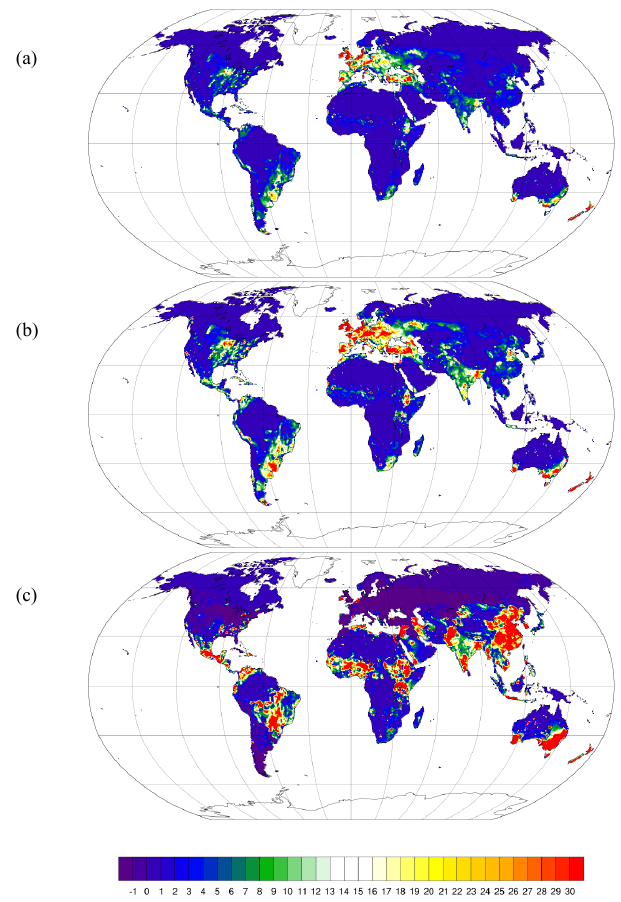
Figure 4. Spatial variation in the annual changing trend of ma- nure nitrogen production (kgNkm − 2 yr − 1 ) during (a) 1860–1910, (b) 1911–1960, and (c) 1961–2014.